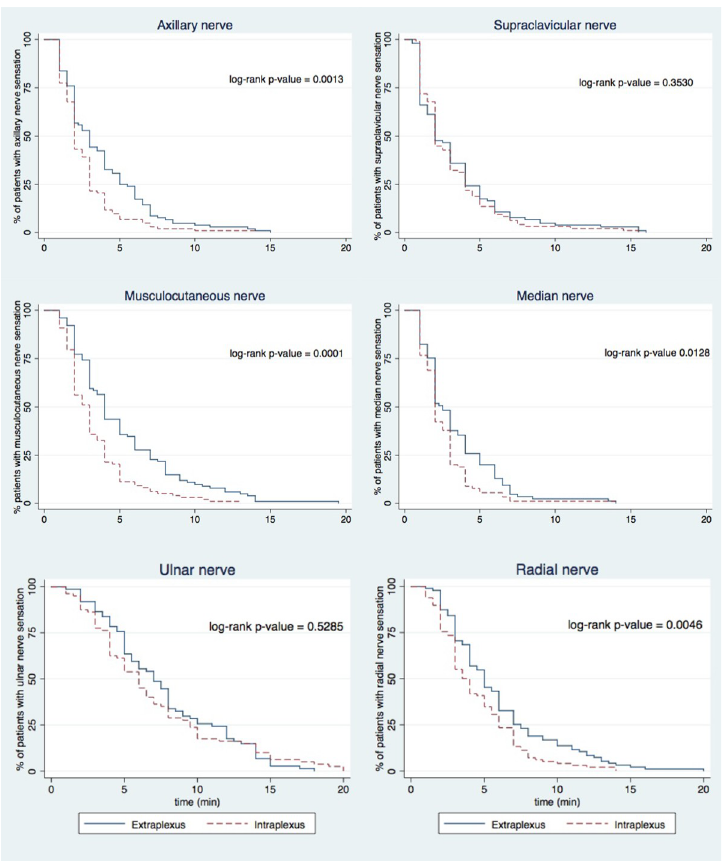
Fig 3. Kaplan-Meier curve of time to onset of sensory blockade. Extraplexus (solid line); intraplexus (dashed line).